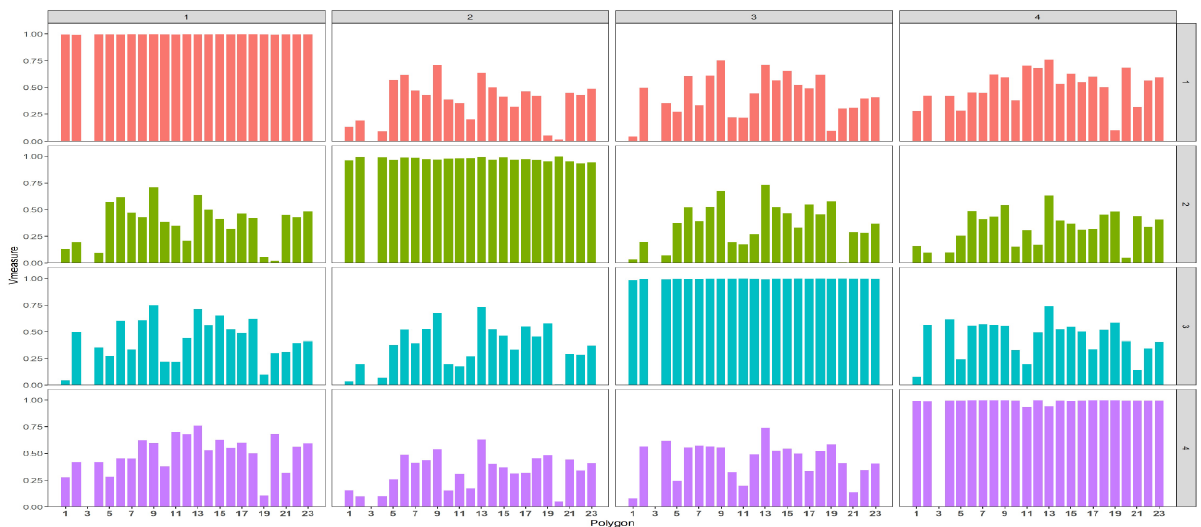
Figure 3. Bar charts of V-measures for each area polygon, for every possible data set pair. V-measures are the same for data set combinations.